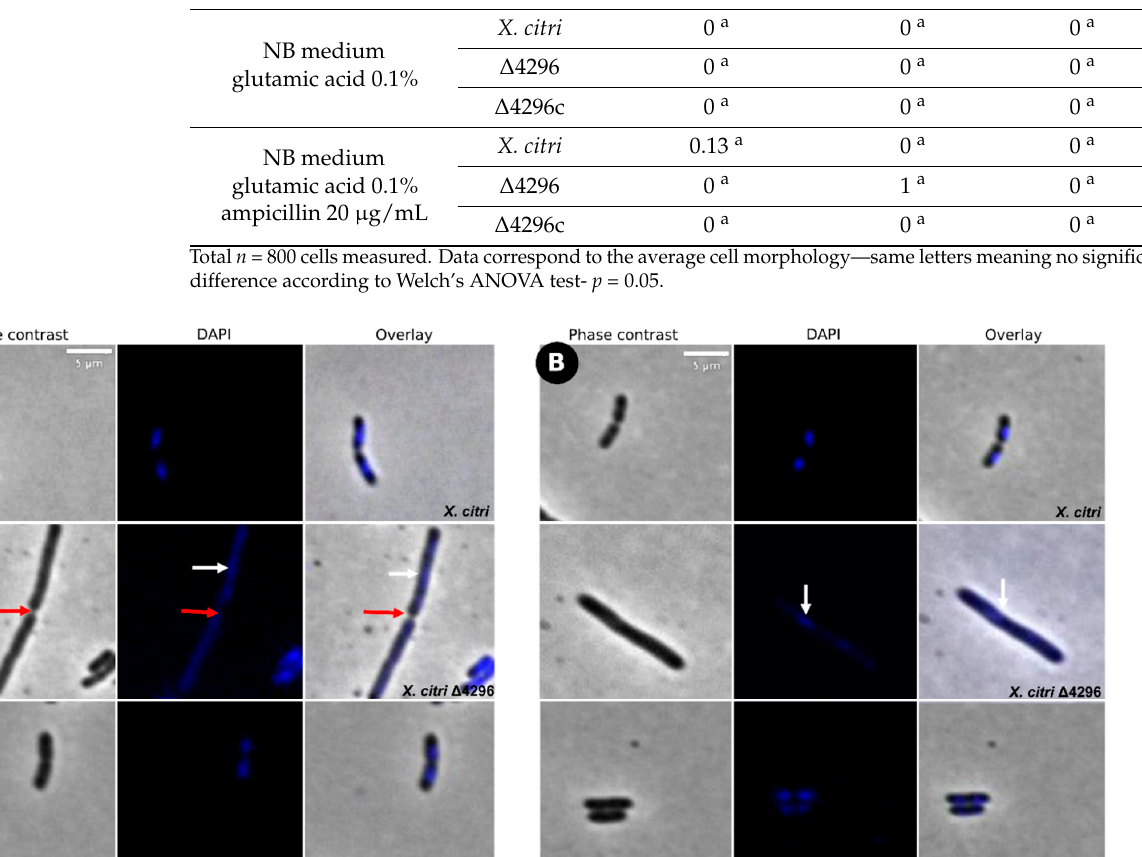
Figure 6. Short filaments, chain phenotype, and nucleoid organization show full reversion in glu- tamate’s presence as carbon source ( A ) Morphological analysis of X. citri , Δ 4296, and Δ 4296c strains on NB supplemented with glutamic acid 0.1% ( w / v ). ( B ) NB supplemented with glutamic acid 0.1% ( w / v ) and ampicillin 20 µg/mL. The figure shows the phase contrast, DAPI, and overlay of the two filters for X. citri, Δ 4296, and Δ 4296c (magnification of 100×)—Scale = 5 µm.